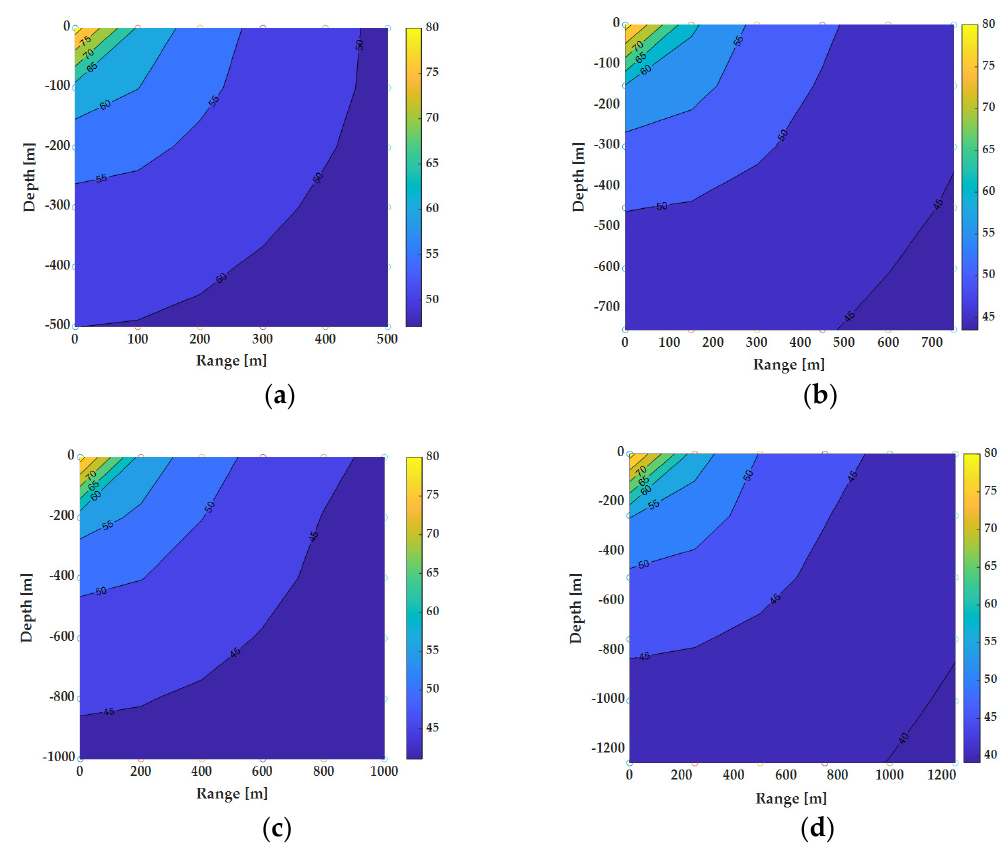
Figure 7. Global acoustic field at different heights: ( a ) z = 500 m; ( b ) z = 750 m; ( c ) z = 1000 m; ( d ) z = 1250 m.